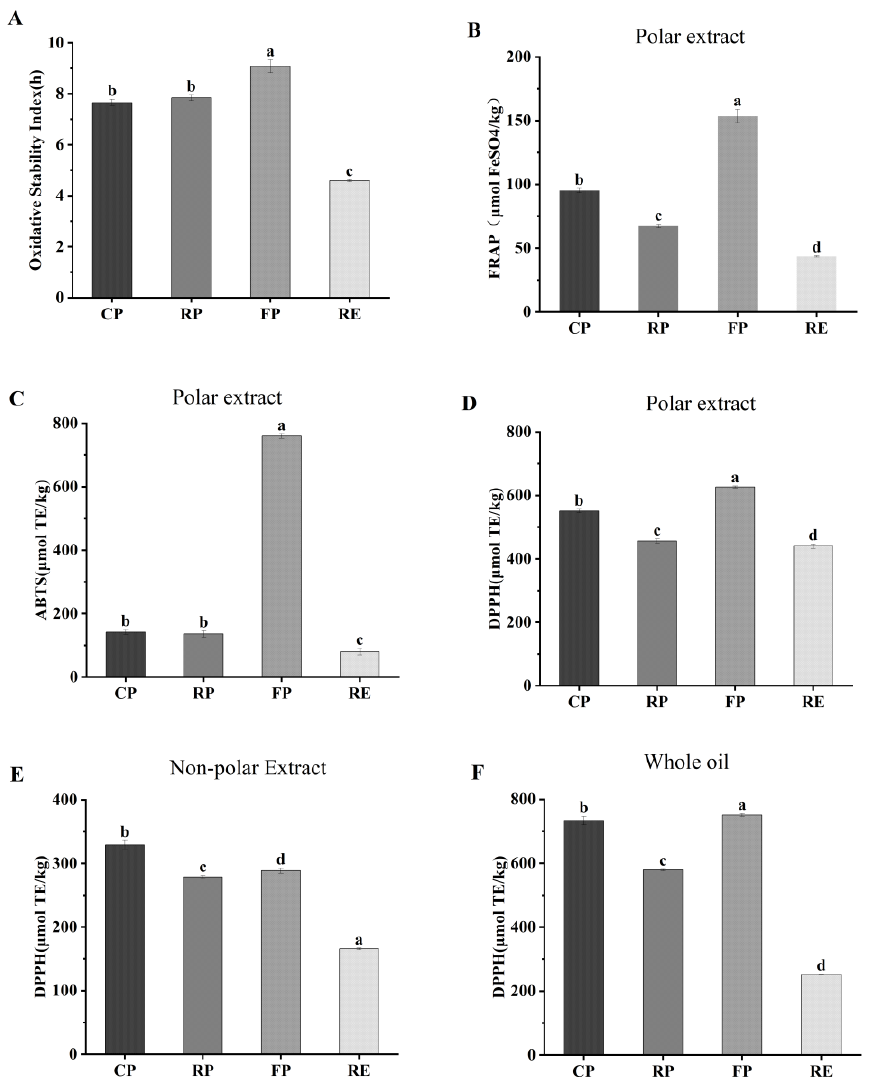
Figure 2. Free-radical scavenging capacity of camellia oil. ( A ) Oxidative stability index (OSI) of camellia oil; ( B ) FRAP assays of polar components in camellia oil; ( C ) ABTS assays of polar components in camellia oil; ( D ) DPPH assays of polar components in camellia oil; ( E ) DPPH assays of non-polar components in camellia oil; ( F ) DPPH assays of whole camellia oil. The superscript letters indicate the statistical difference in rows at a significant level of 5%. CP, cold-pressed camellia oil; RP, roast-pressed camellia oi; HP, fresh-pressed camellia oil; RE, refined camellia oil.